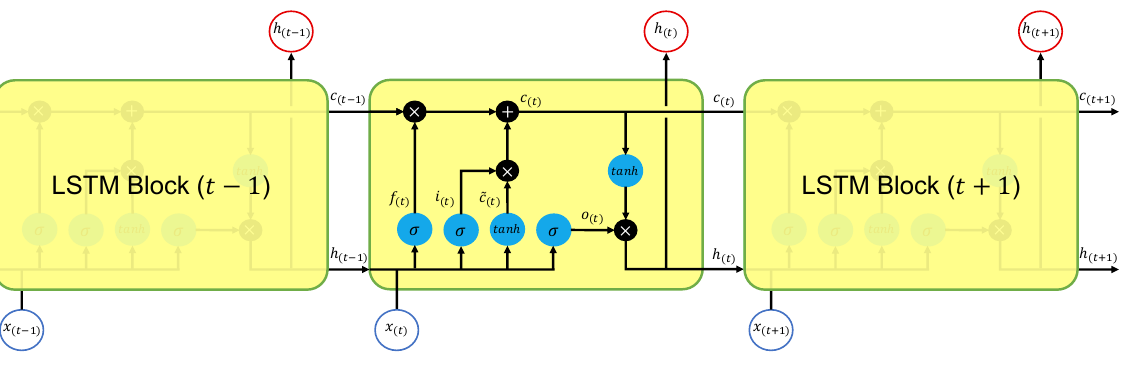
Figure 5. Architecture of the LSTM